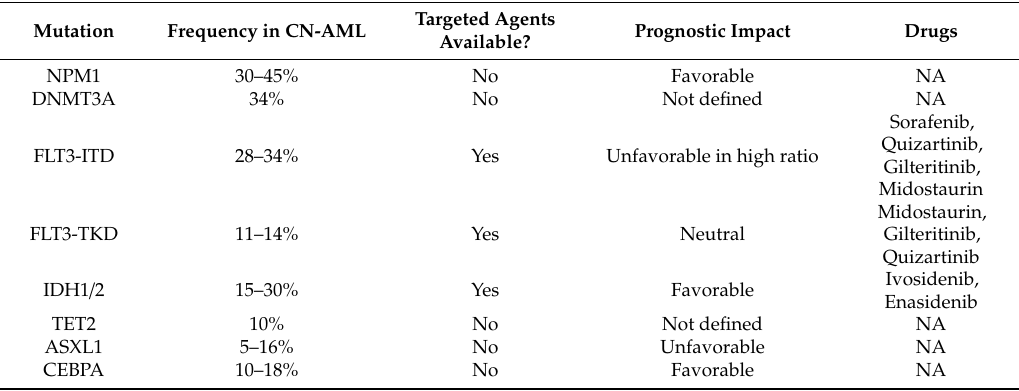
Table 1. Mutational scenario in